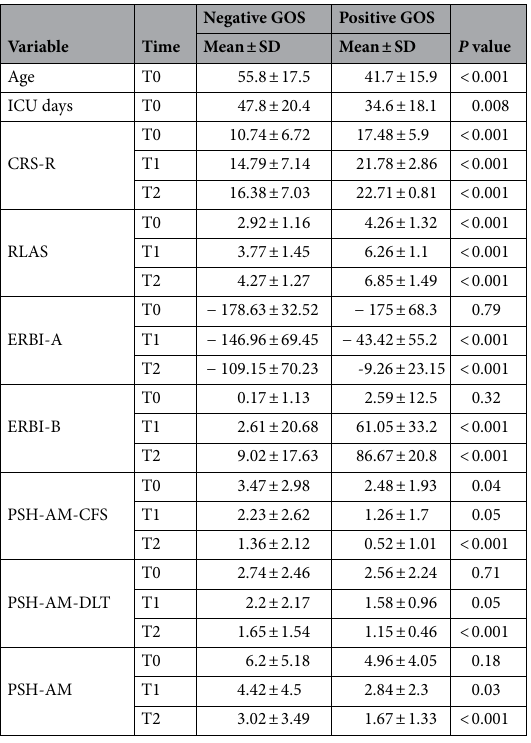
Table 1. Means and standard deviations of continuous demographic and clinical predictors at baseline (T0), after 4 months from the event (T1) and at discharge (T2) according to the GOS binary categorization (positive/negative). GOS Glasgow outcome scale, ICU intensive care unit, CRS-r coma recovery scale-revised, RLAS Rancho Los Amigos Scale, ERBI early rehabilitation Barthel index, PSH-AM paroxysmal sympathetic hyperactivity-assessment measure, CFS clinical feature scale, DLT diagnosis likelihood